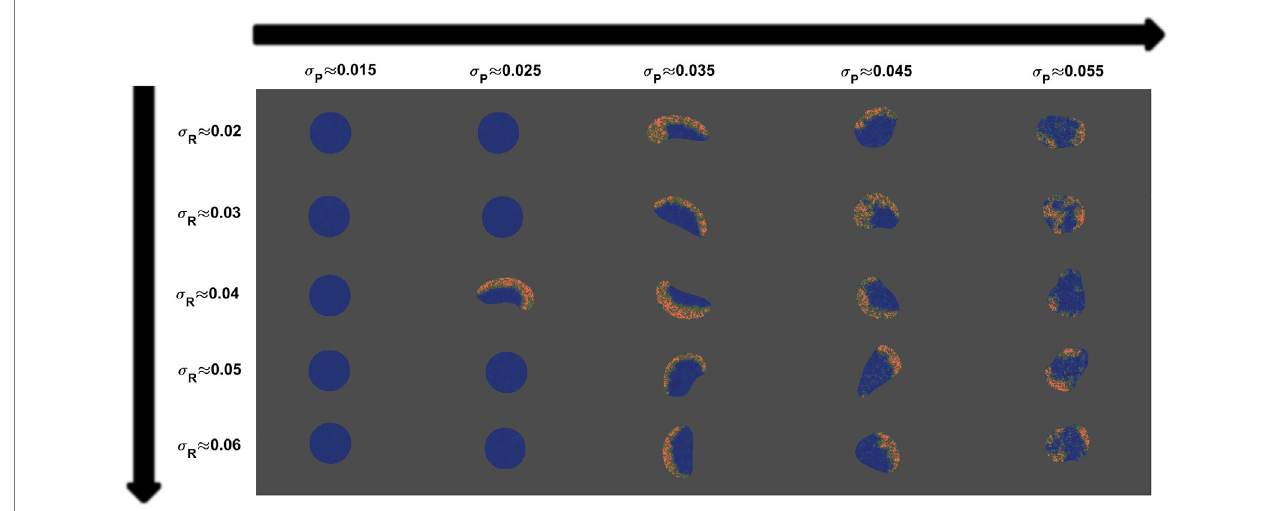
FIGURE 5 | Map of snapshots of the virtual cell taken from different variance values of noise intensity for the original model [23]. For each column, snapshots indicate P distribution (red) inside the cell. The value of the parameter of the simulations are k 14 = 10.2 s − 1 and k 18 = 7 s − 1 . The rest of them are consistent with Supplementary Table S1